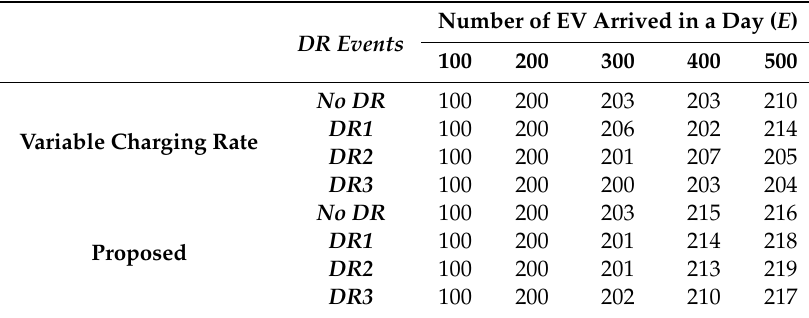
Table 4. Comparison of Number of Fully Charged EVs.